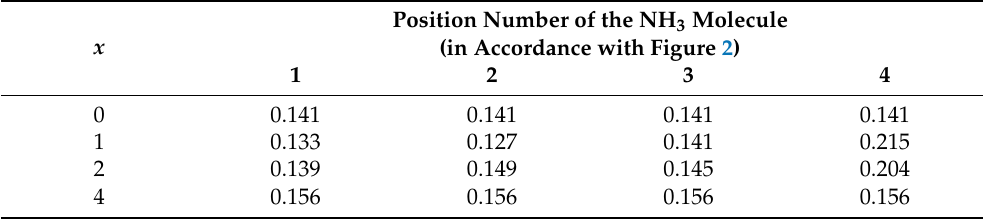
Table 2. Binding energies (in eV) of each of the four NH 3 molecules in ZnPc- x py/4NH 3 aggregates.